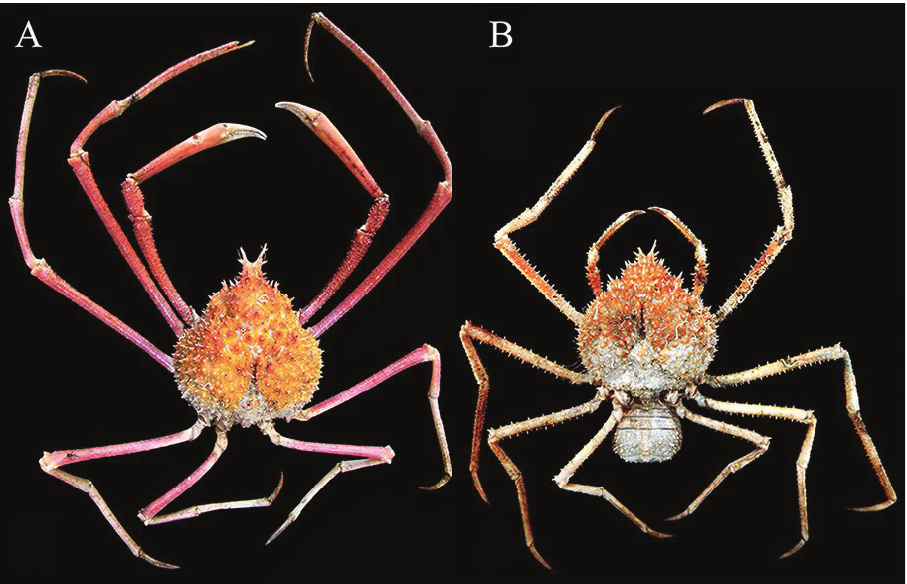
Figure 1. Pleistacantha kannu sp. n., colour in life. A holotype male (cl 106.2 mm, cw 87.0 mm) (CASAU), India B paratype ovigerous female (cl 84.4 mm, cw 71.5 mm) (CASAU),